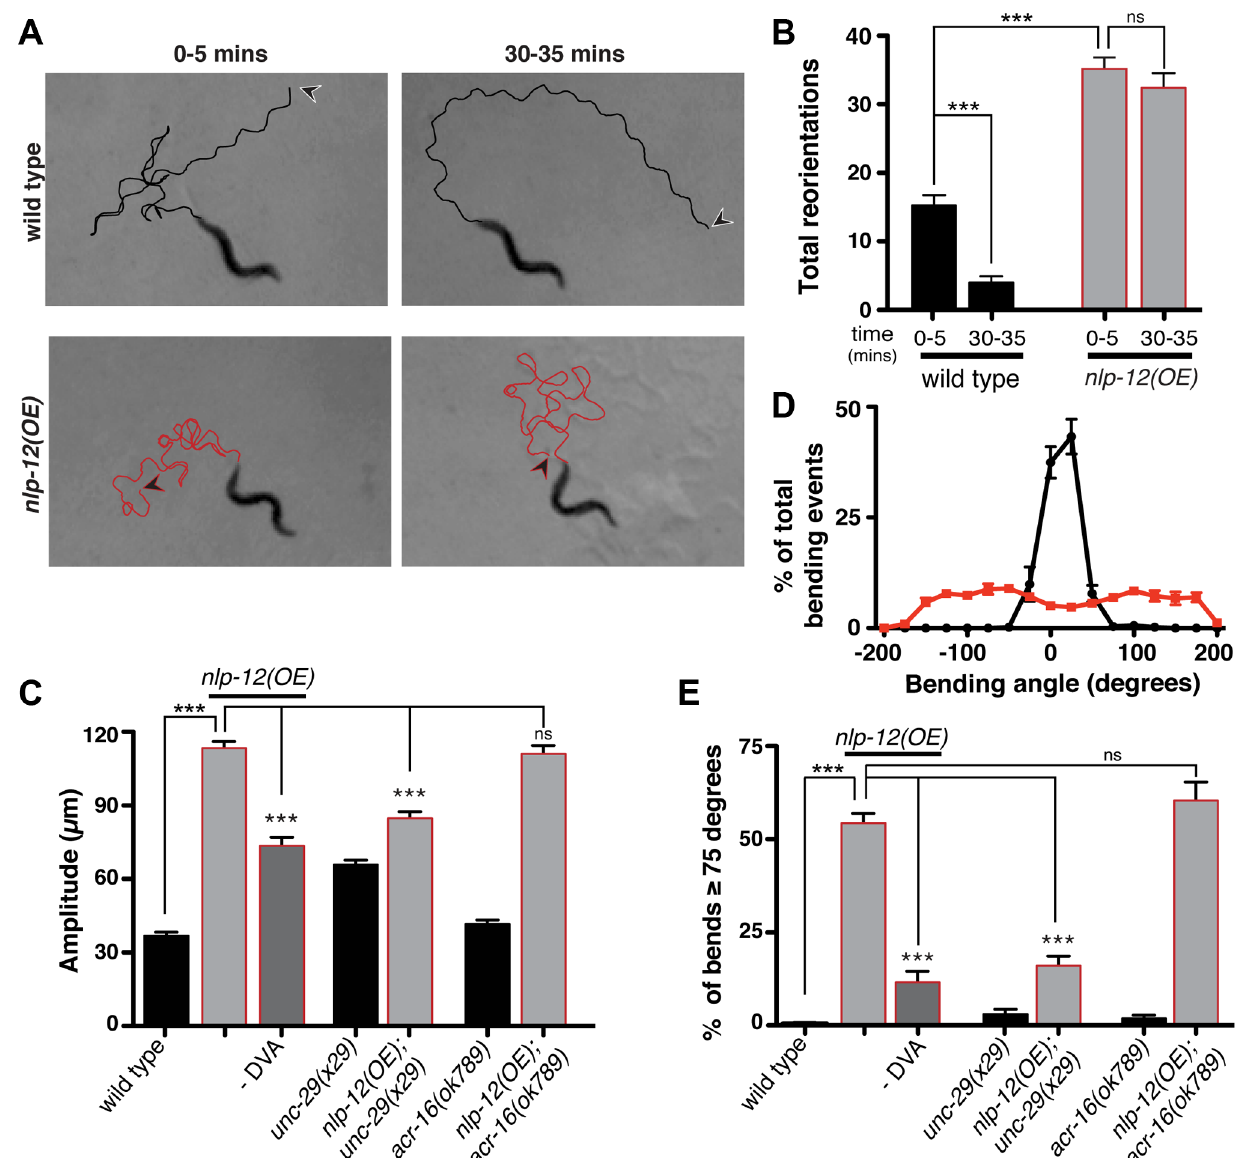
Figure 5. Elevated NLP-12 signaling induces a chronic local search-like state. ( A ) Representative tracks (45 s) of wild type (black lines) and nlp-12(OE) (red lines) animals during 0–5 and 30–35 minute intervals after removal from food as indicated. nlp-12(OE) refers to a transgenic strain ( ufIs104 ) stably expressing high levels of the wild type nlp-12 genomic sequence. Note that high angled reorientations still persist during the 30– 35 minute interval for nlp-12(OE) in contrast to the long forward run of the wild type animal. The starting point of each track is indicated by an arrowhead (wild type: black; nlp-12(OE) : red). ( B ) Total directional reorientations measured during 0–5 and 30–35 minute intervals following removal from food for wild type (n=8) and nlp-12(OE) (n=15) animals. ( C ) Average body bend amplitude for the genotypes indicated. –DVA refers to DVA ablation (WT: n=11, nlp-12(OE) : n=15, nlp-12(OE) -DVA: n=10, unc-29 : n=30, unc-29;nlp-12(OE) : n=22, acr-16 : n=16, acr-16;nlp-12(OE) : n=15). ( D ) Frequency distribution of bending angles for wild type (black) and nlp-12(OE) (red) animals monitored on bacteria seeded plates for 30 s (WT: n=12, nlp-12(OE) : n=15). ( E ) Bar graph depicting total percentage of bending angles $ 75 u for the genotypes indicated (WT: n=12, nlp-12(OE) : n=14, nlp- 12(OE) -DVA: n=9, unc-29 : n=10, unc-29;nlp-12(OE) : n=12, acr-16 : n=10, acr-16;nlp-12(OE) : n=12). Note that wild type worms rarely execute bends $ 75 u . Bars represent mean ( 6 SEM). For (B), (C) and (E) ***, p , 0.0001 by ANOVA with Sidak’s post-hoc test.